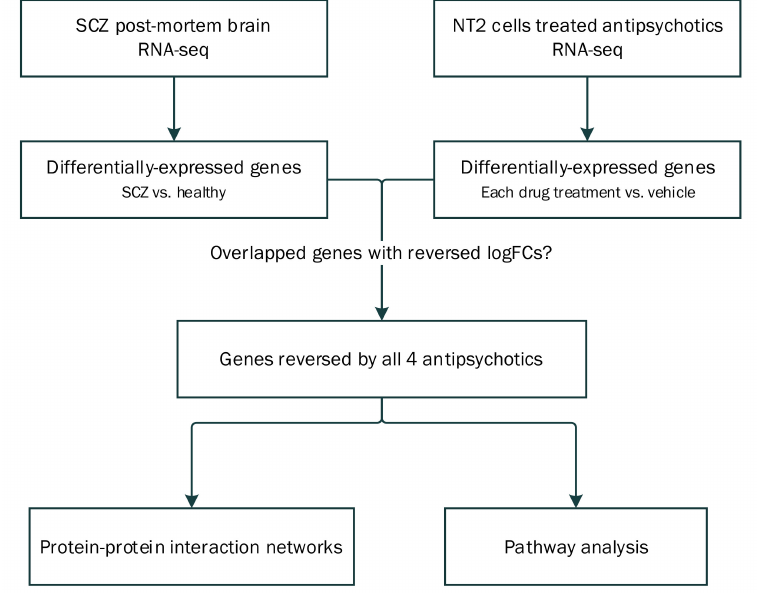
Figure 1. Flowchart of the analytical approach of the current study. Schizophrenia-associated transcrip- tional perturbations were compared against drug-induced gene expression profiles to identify